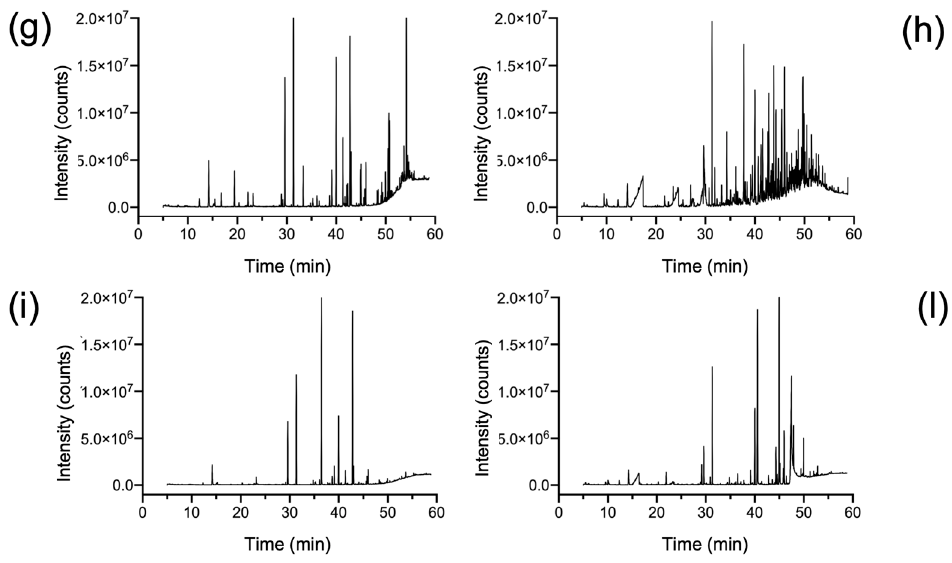
Figure 1. Total ion chromatograms of ( a ) PET (t 0 ); ( b ) PET (t 0 + 4 w); ( c ) HDPE (t 0 ); ( d ) HDPE (t 0 + 4 w); ( e ) LDPE (t 0 ); ( f ) LDPE (t 0 + 4 w); ( g ) PP (t 0 ); ( h ) PP (t 0 + 4 w); ( i ) PS (t 0 ); and ( l ) PS (t 0 + 4 w).